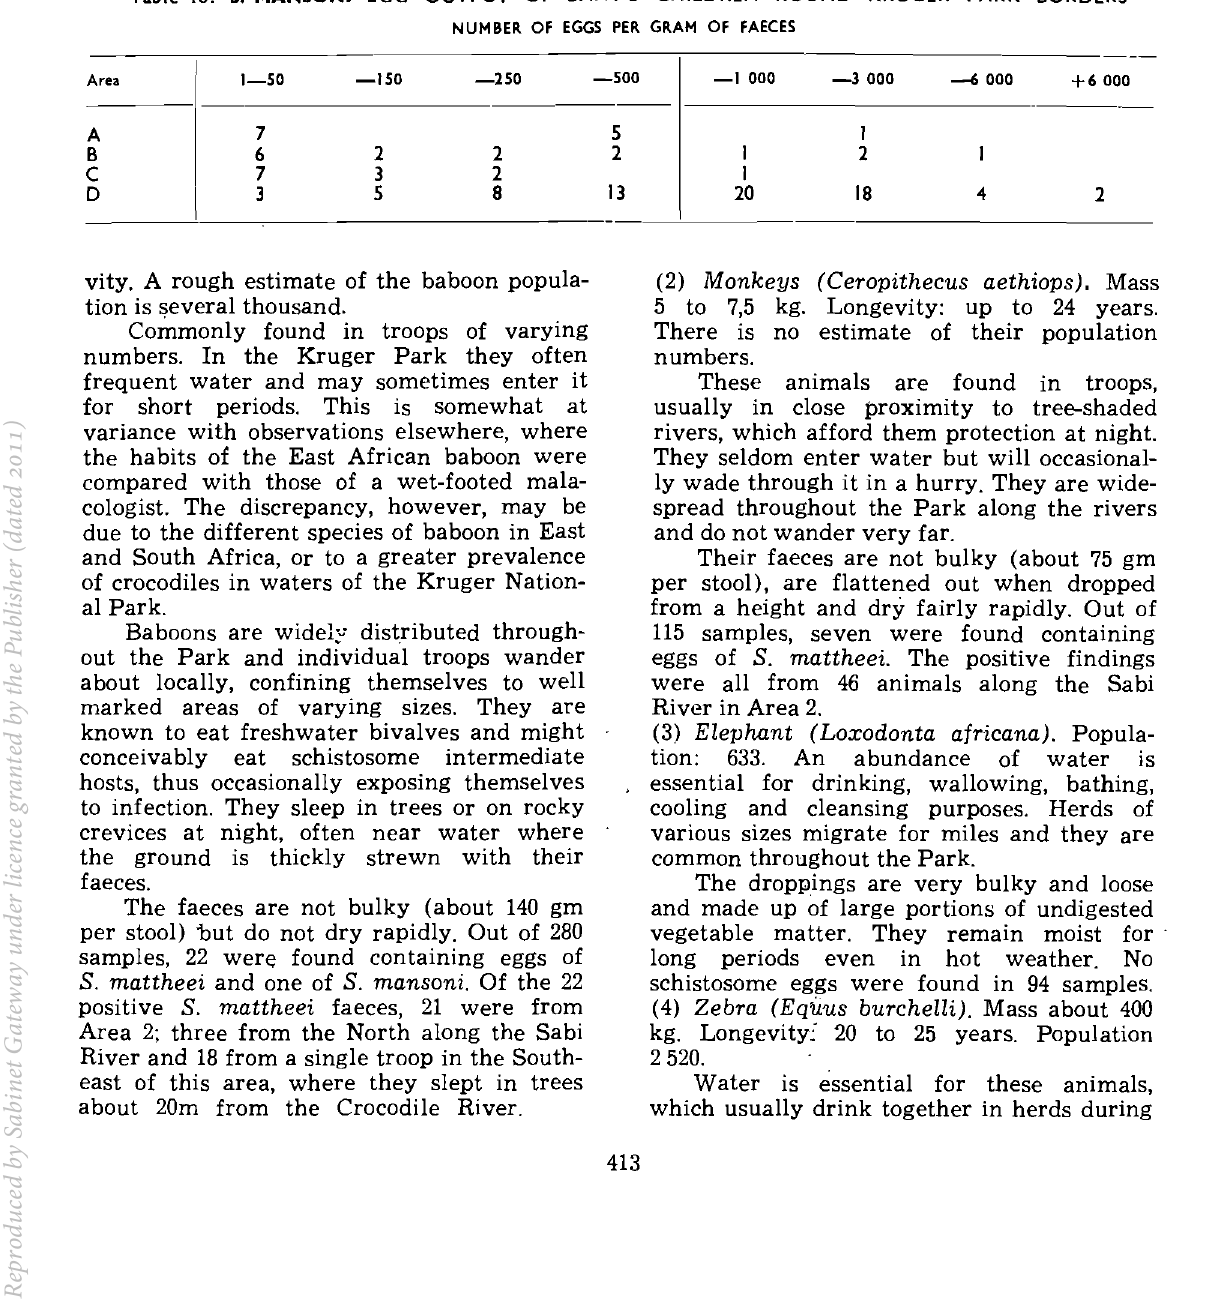
Table 10: S. MANSON I EGG OUTPUT OF BANT U CHILDREN ROUND KRUGER PARK